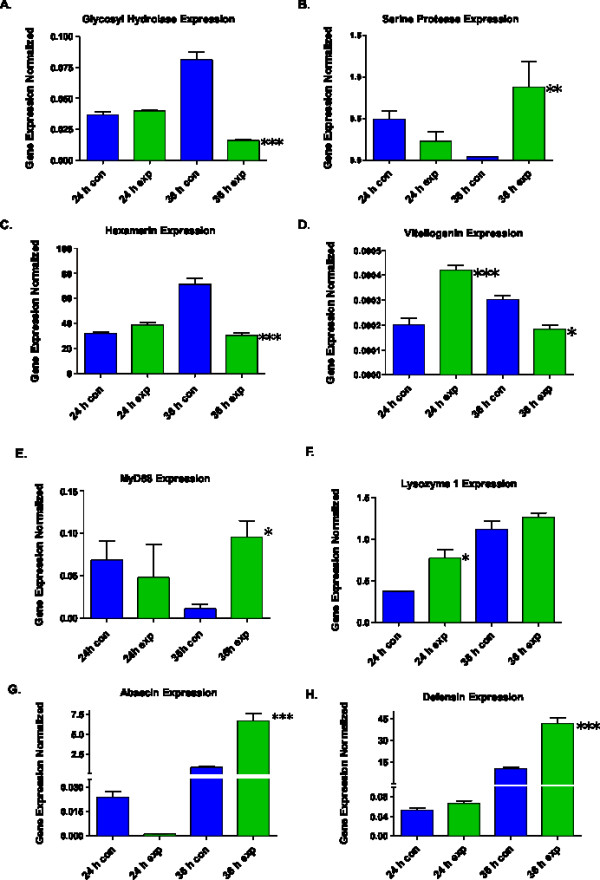
qRT-PCR analysis of selected cDNA-AFLP transcripts (A-C) and transcripts not derived from cDNA-AFLP (D-H):. (A) Glycosyl Hydrolase, (B) Serine Protease, (C-D) storage proteins Hex 70b and Vg, and (E-H) components on the honey bee immune response pathways including anti-microbial peptides. Control group of samples are represented by blue bars, the experimental samples are represented by green bars. Samples were done in triplicate and normalized by dividing the amount (pg or fg as described in Materials and Methods) of the gene of interest by the amount for the housekeeping gene, actin. Results are reported as an average of the triplicates plus the standard deviation. Significant by ANOVA at P < 0.05(*), P < 0.01(**), and P < 0.001(***).